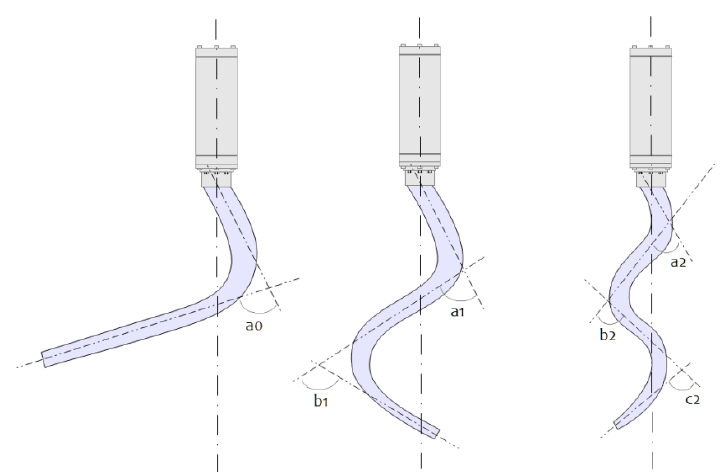
Figure 8. Bending types and reference angles.